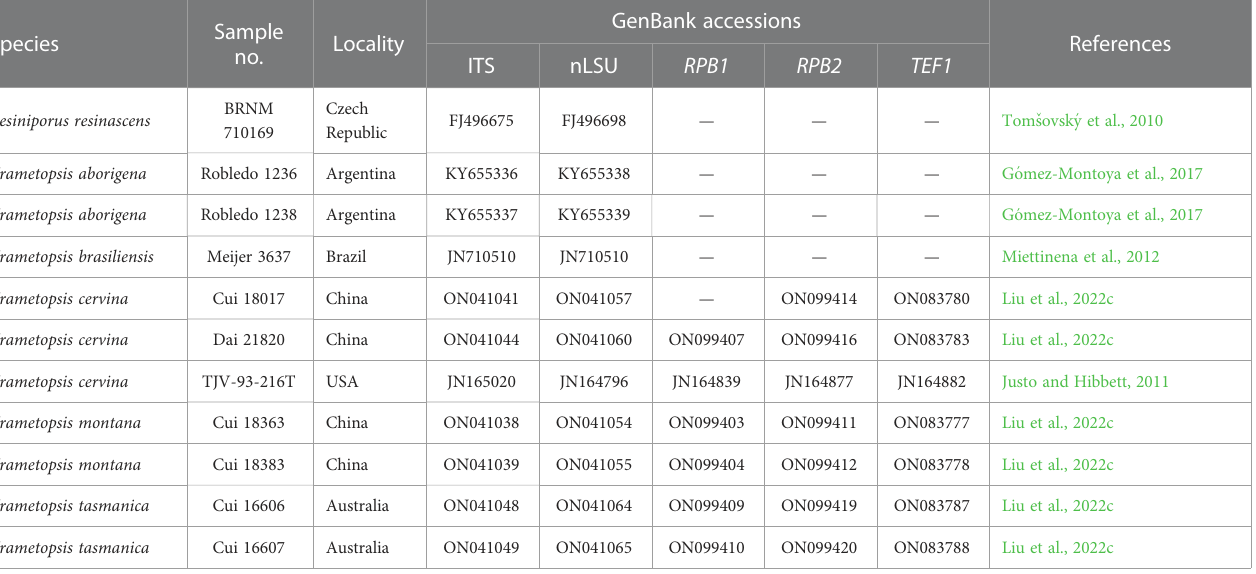
analysis resulted in a similar topology as MP and Bayesian analyses, and only the ML topology is shown in Figure 1.